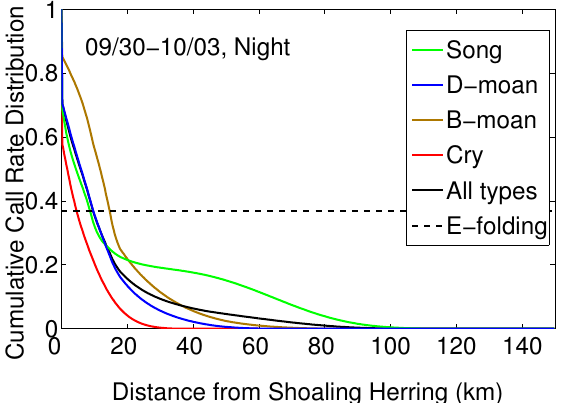
Figure 9. Cumulative nighttime humpback vocalization rate distribution for different call types as a function of minimum distance from nighttime herring shoaling areas. The results are averaged over nighttime hours from 30 September to 3 October 2006. The humpback cry vocalizations have the smallest e-folding distance and are most tightly distributed in and around dense herring shoaling